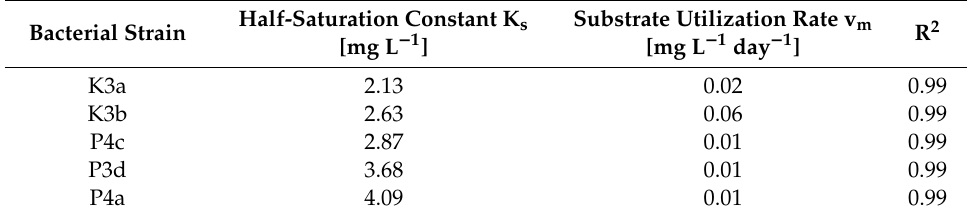
Table 2. The kinetics parameters according to the Monod equation describing nitrofurantoin biodegradation by strains Sphingomonas paucimobilis (K3a), Ochrobactrum antrophi (K3b), Rhizobium radiobacter (P4c), Pseudomonas aeruginosa (P4a), and Sphingobacterium thalpophilum